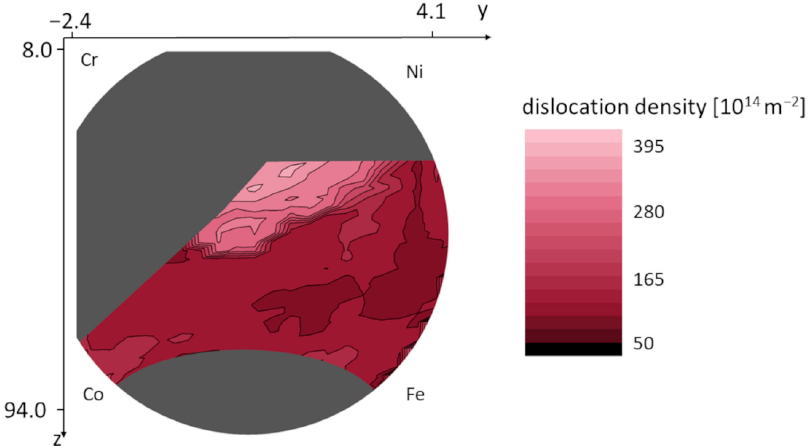
Figure 8. Variation of the dislocation density in the FCC region of the combinatorial Co-Cr-Fe-Ni CCA film.